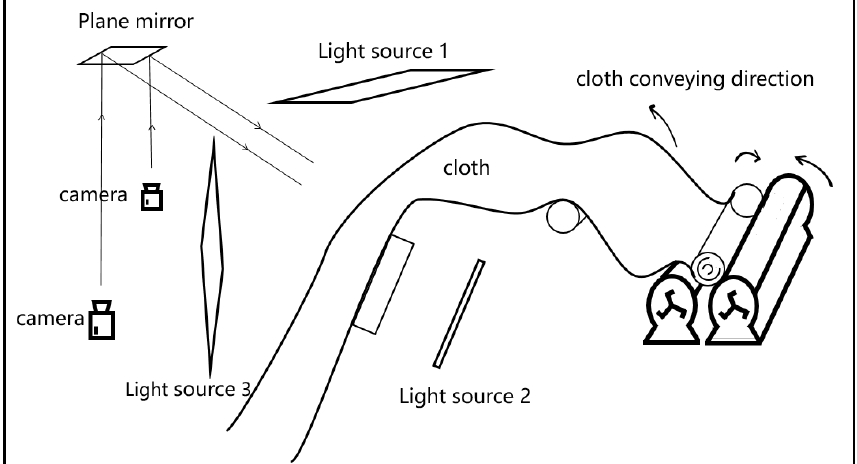
Figure 7. The internal structure diagram of the developed automatic cloth inspection